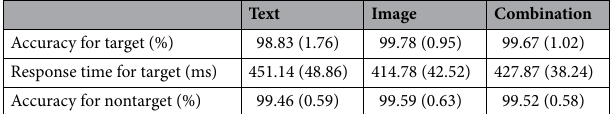
Table 1. Accuracy and response time in the oddball task (SD).